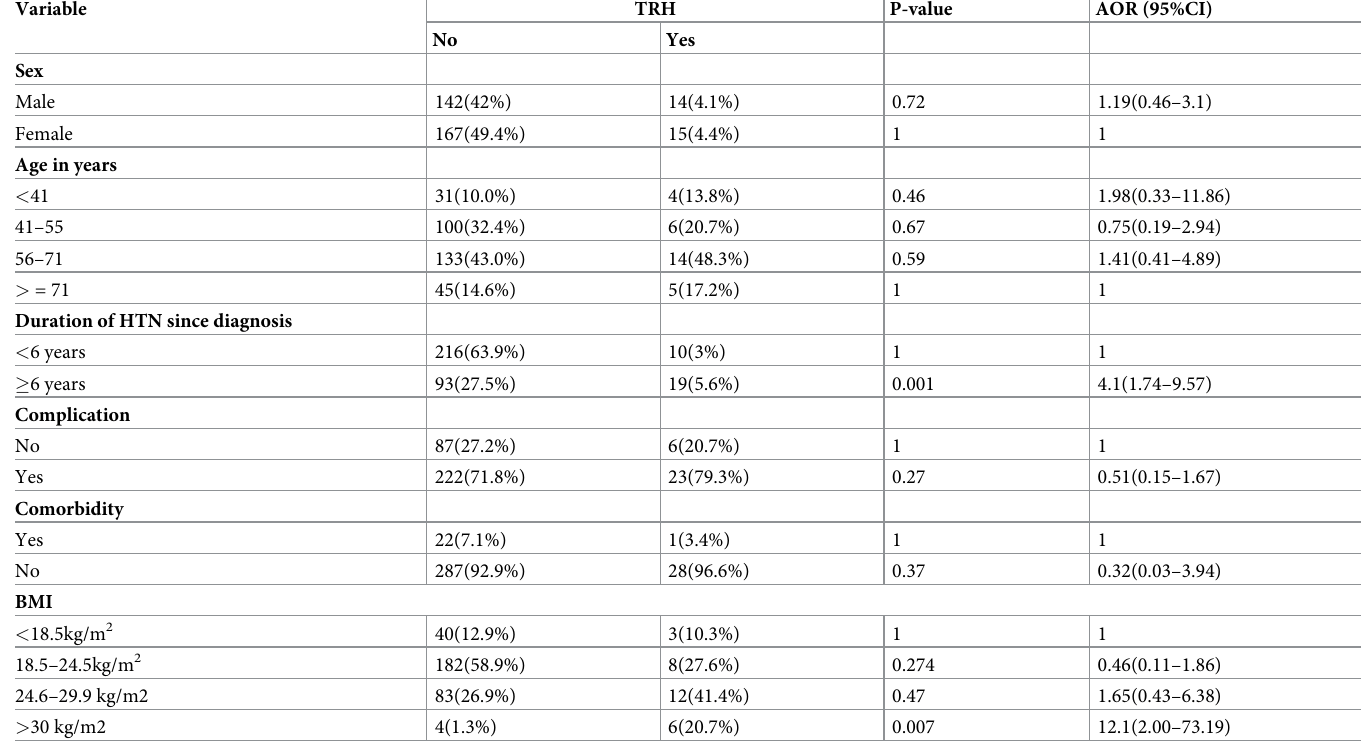
Table 4. Multivariate logistic regression analysis of factors associated with treatment resistant hypertension among adult ambulatory hypertensive patients in Mekelle Hospital,